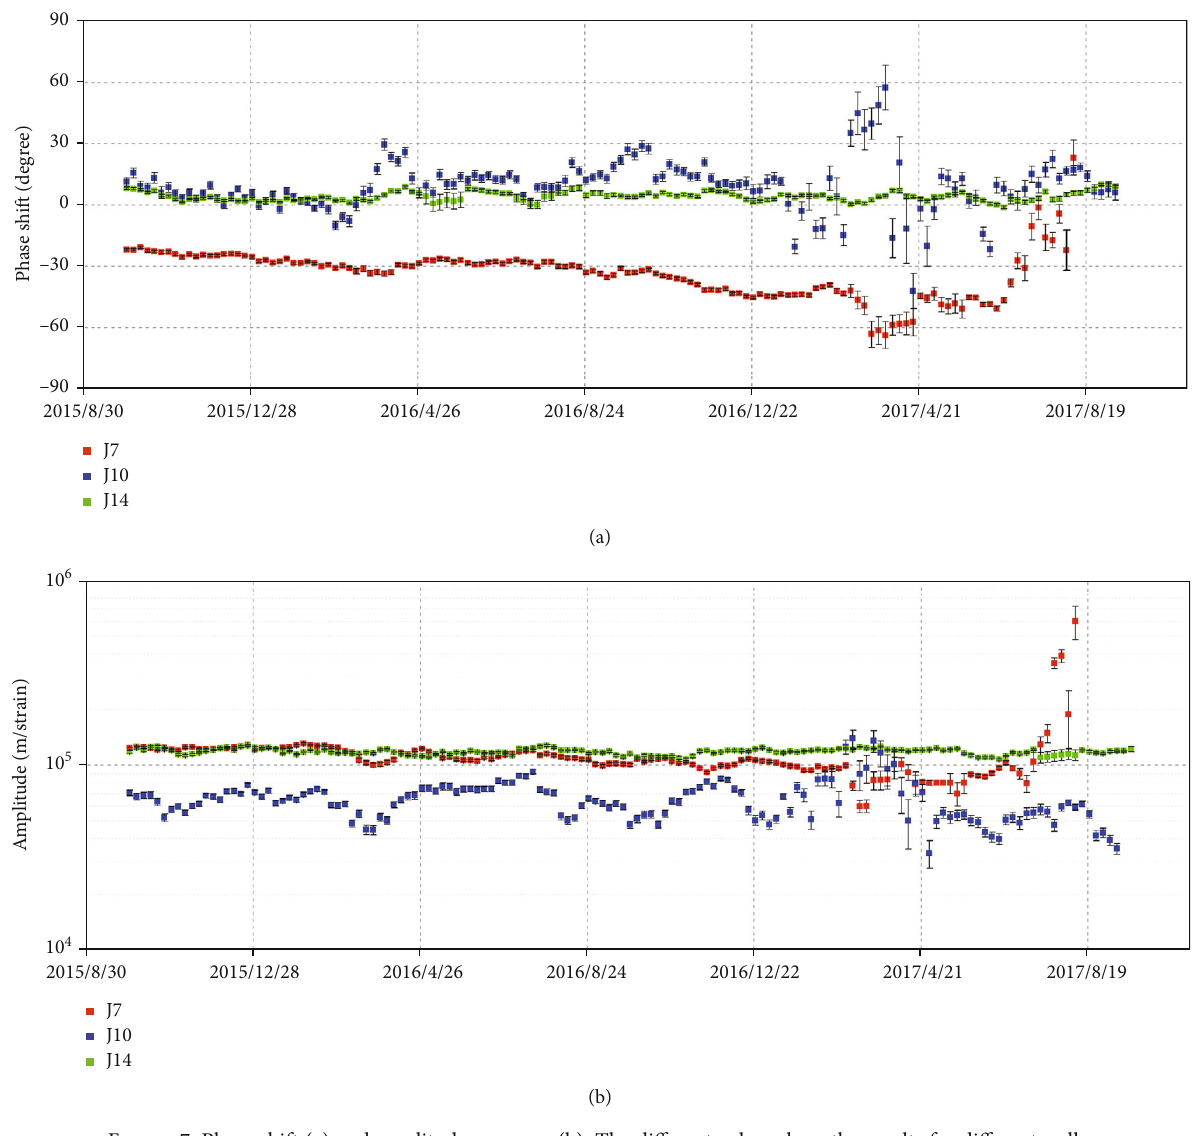
Figure 7: Phase shift (a) and amplitude response (b). The di ff erent colors show the results for di ff erent